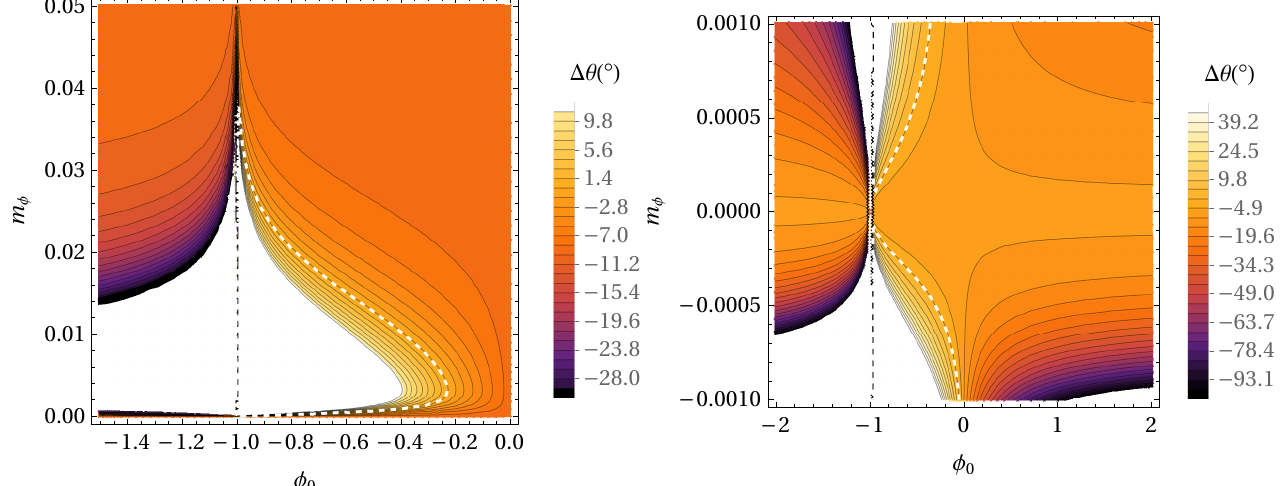
Figure 4. The same as in Figure 3, but for the mass density distribution ρ 0 = 4 × 10 8 M (cid:12) pc − 3 . The right panel represents the same as the left panel but for smaller values of the m φ